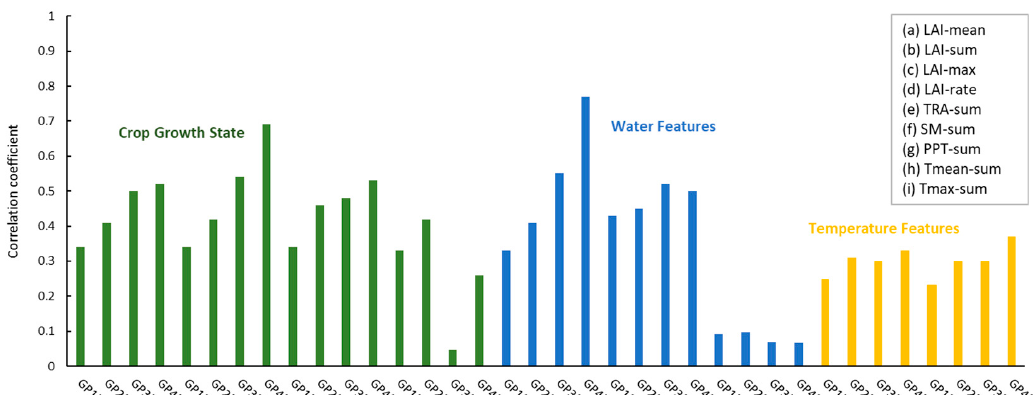
Figure 6. Correlation Analysis Results of Each Feature in Four Growth Phases. LAI-mean is the mean value of LAI, LAI-sum is the cumulative value of LAI, LAI-max is the maximum value of LAI, LAI-rate is the growth rate of LAI, TRA-sum is the cumulative value of TRA, SM-sum is the cumulative value of SM, PPT-sum is the cumulative value of PPT, Tmean-sum is the cumulative value of Tmean, and Tmax-sum is the cumulative value of Tmax.